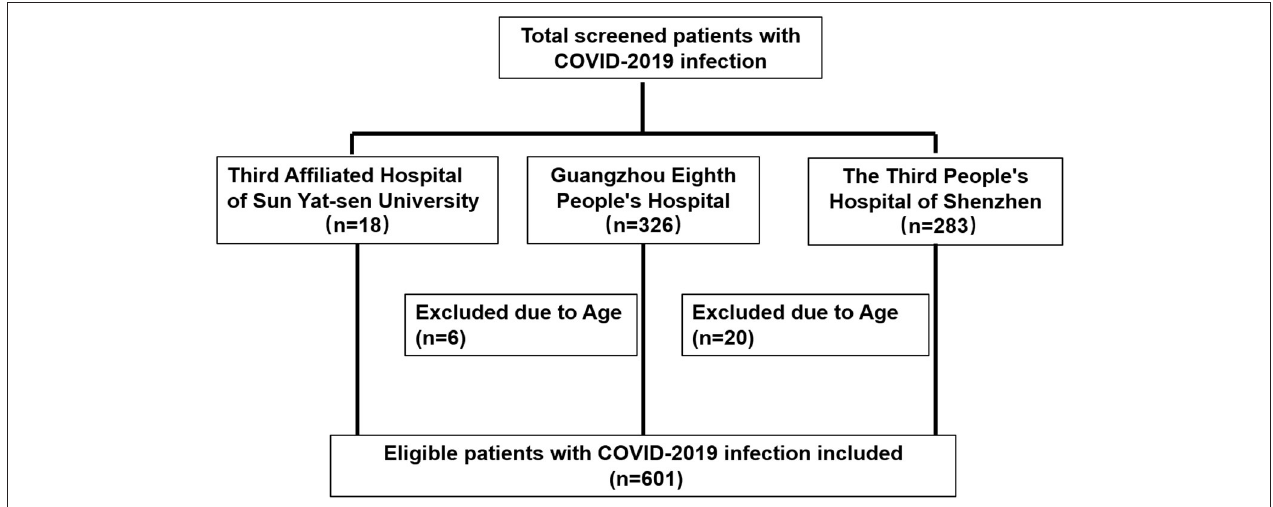
FIGURE 1 | Flowchart of study participants in